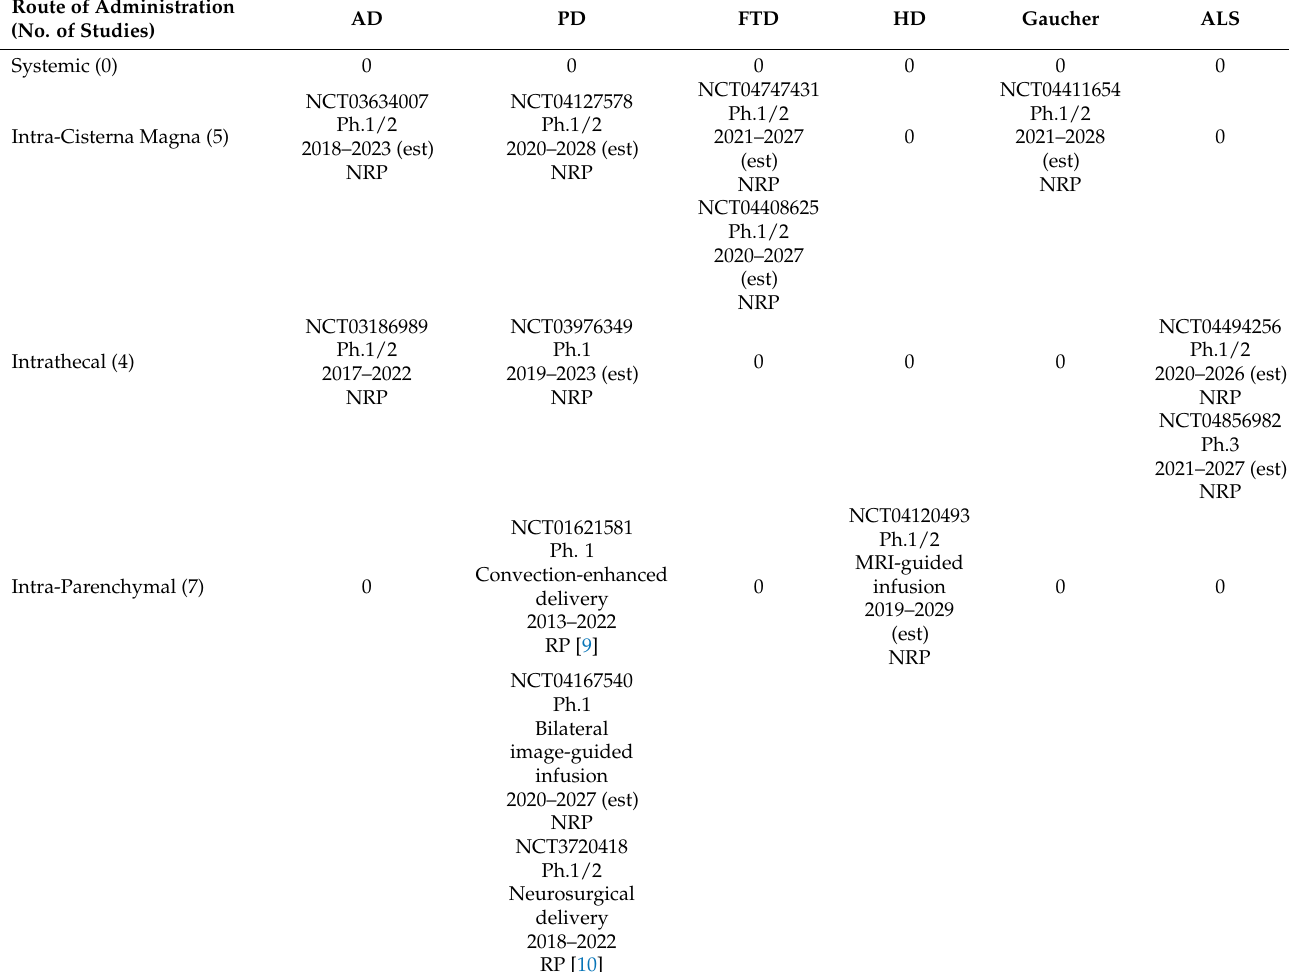
Table 2. On-going Gene Therapy Trials and Routes of Administration by Disease